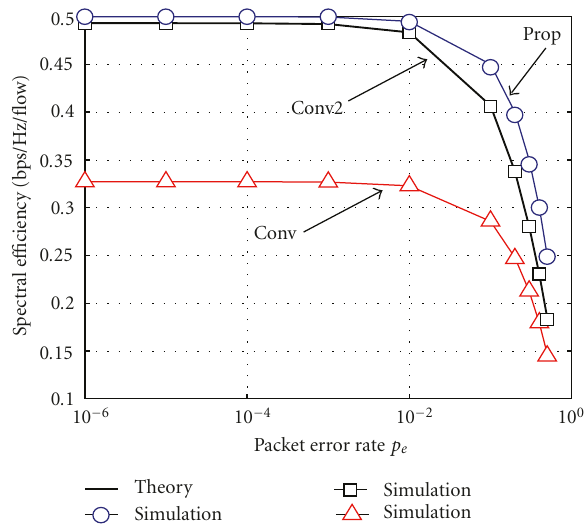
Figure 11: Analysis result of the proposed retransmission scheme for two-way relay. (Bold lines: theoretical results, Markers: simula- tion